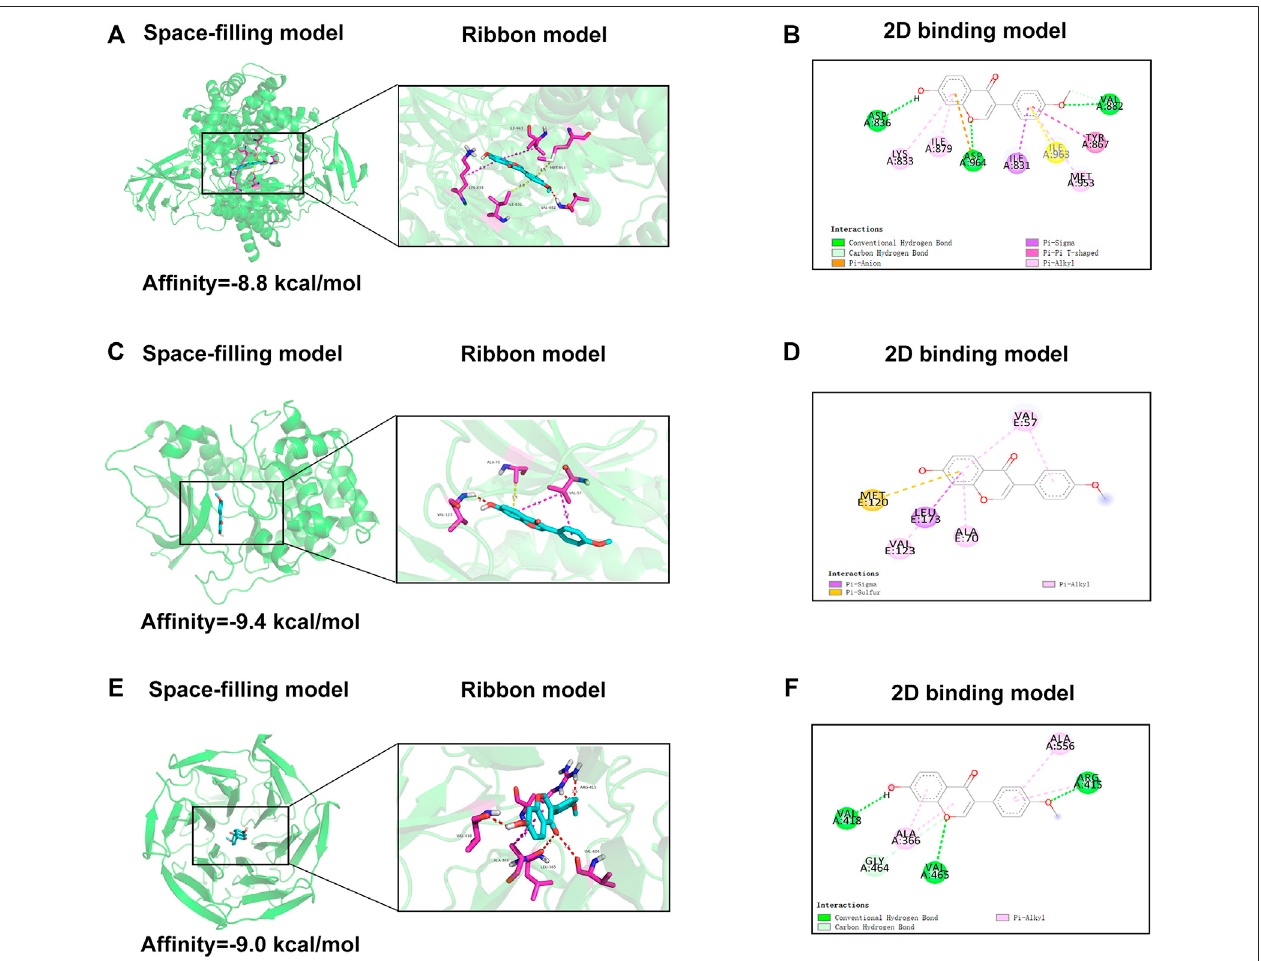
FIGURE 8 | (A,C,E) The space- fi lling models and the ribbon models of FMNT with PI3K, Akt and Nrf2-Keap1 complex (B,D,F) The 2D binding models between FMNT and PI3K, Akt and Nrf2-Keap1 complex.